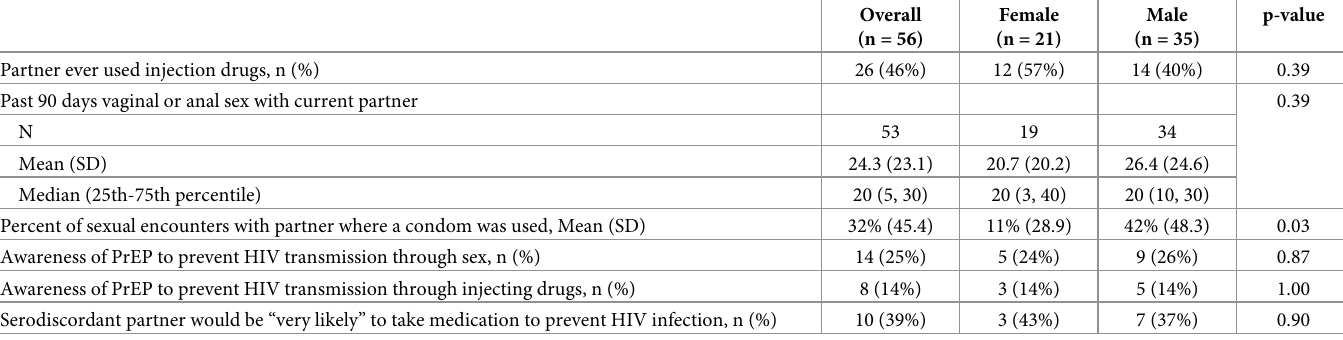
Table 4. Partner-specific HIV risk behaviors and PrEP awareness among sub-sample of participants who reported being partnered (n =